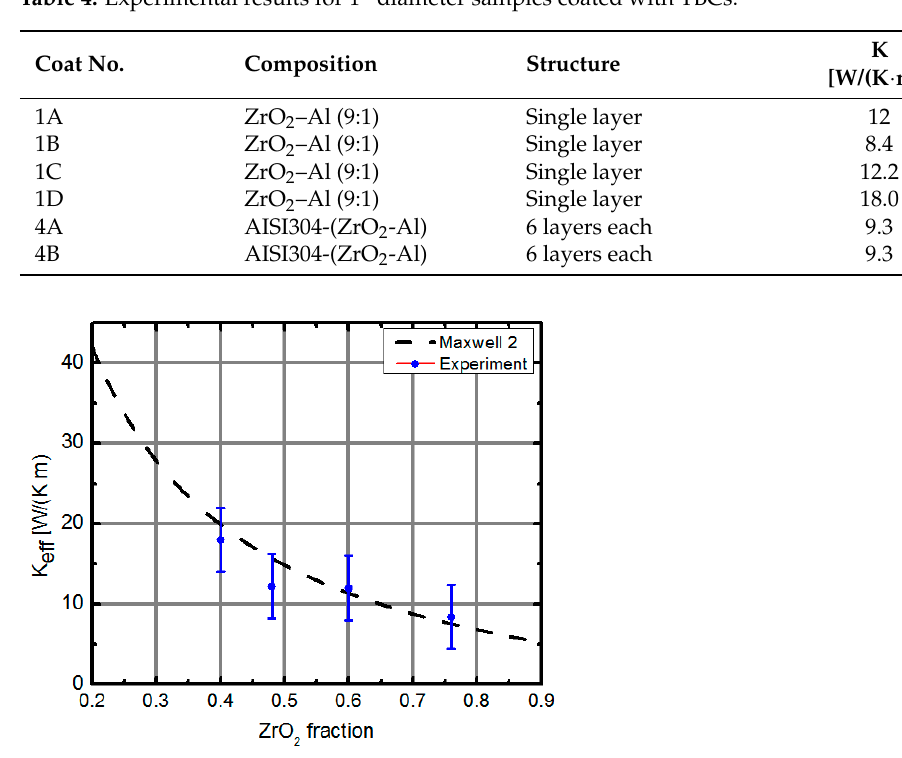
Figure 10. The ME2 curve with the experimental values of thermal conductivity for the homogenous coatings (blue points). coatings (blue